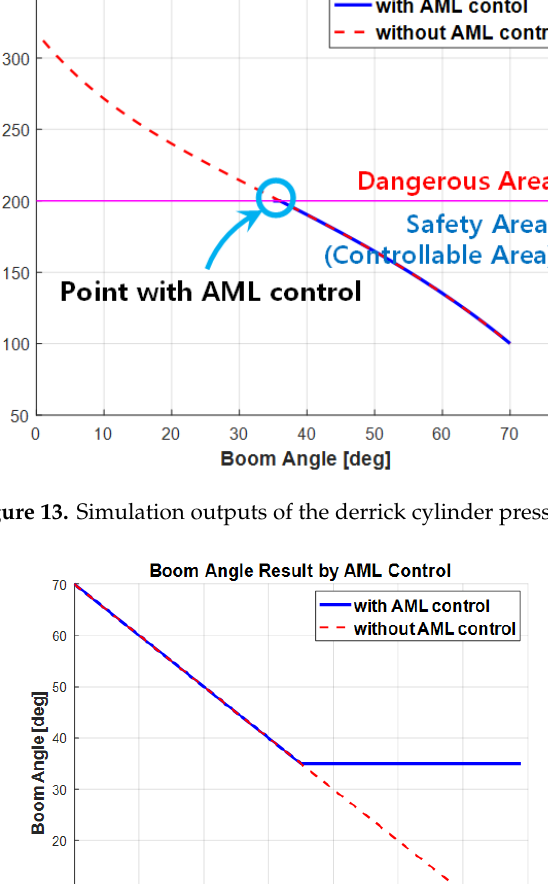
Figure 14. Boom angle simulation outputs with AML control.